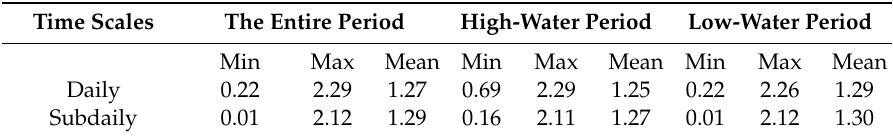
Table 2. Statistics of the daily and subdaily α .